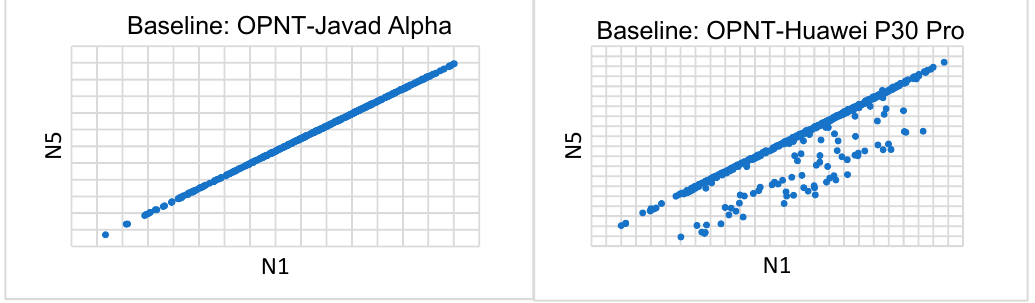
Figure 24. Time series of correlated double-di ff erence float single epoch N1–N5 solutions for a pair of G06–G26 satellites (500